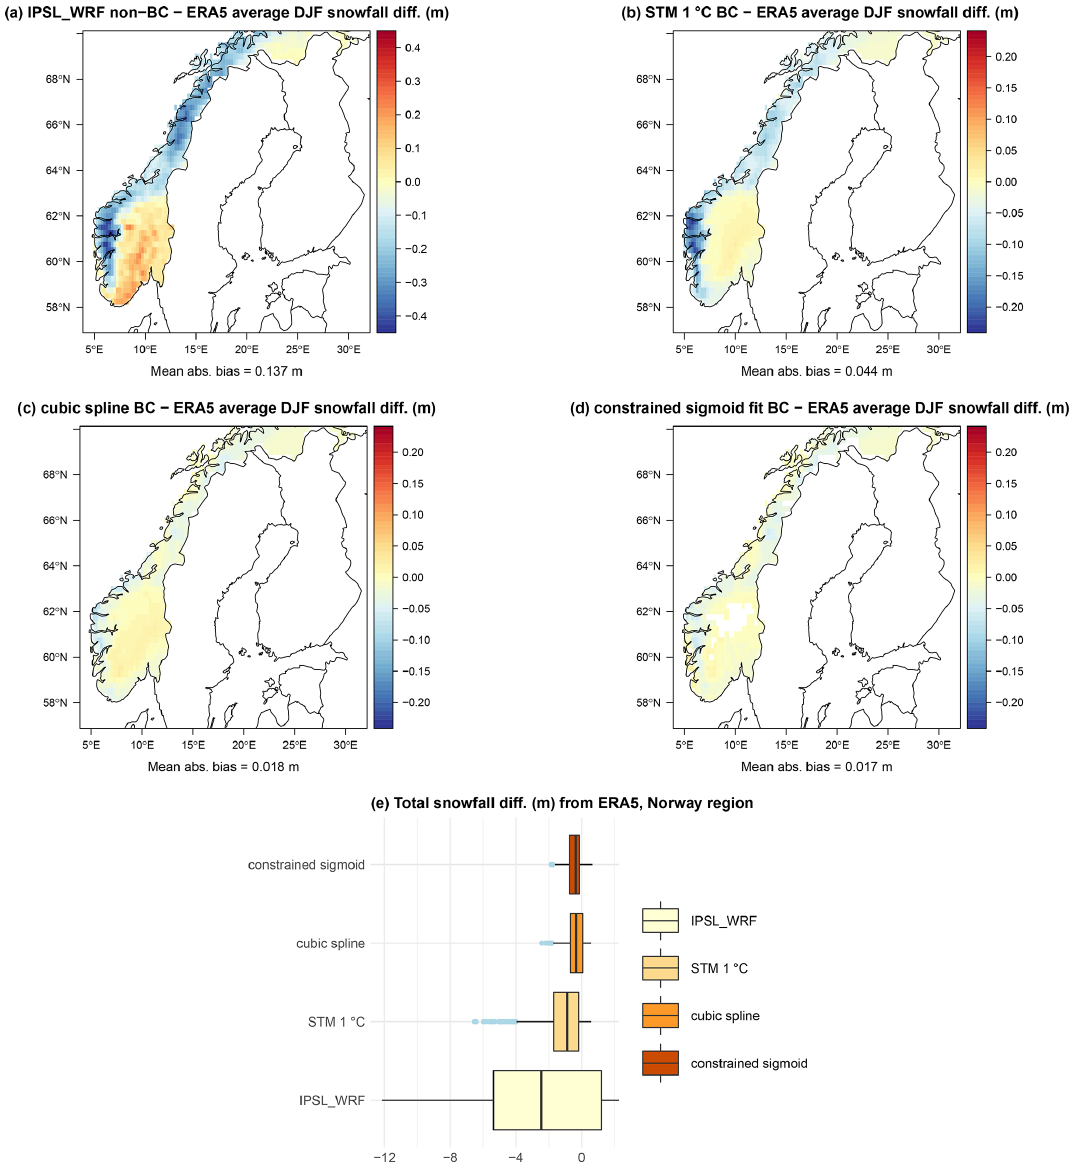
Figure 11. Maps of average 1979–2005 DJF snow differences over Norway between raw IPSL_WRF (a) , STM (b) , cubic spline regres- sion (c) , sigmoid fit (d) bias correction, and ERA5. Corresponding summary box plots are shown in panel (e)